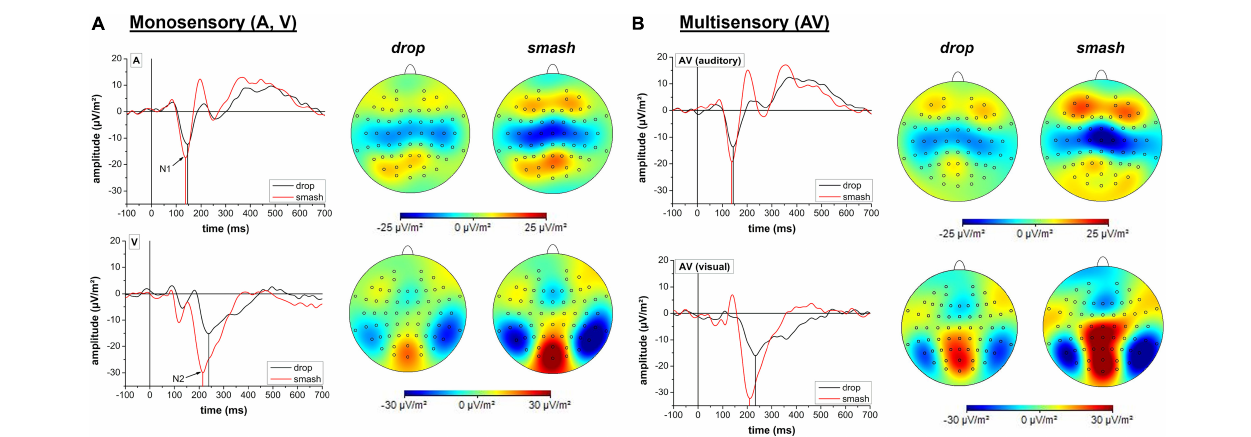
FIGURE 5 | Temporal profile and cortical mapping reflecting auditory and visual activity in drop (black line) and smash (red line) strokes for monosensory (A) and multisensory (B) stimulation conditions. Cortical potentials of interest (N1, N2) are highlighted with arrows. Cortical mappings are based on a 10 ms peri-peak window centered at the N1 or N2 potential peak. Note different scaling for the mappings corresponding to the auditory N1 and visual N2.